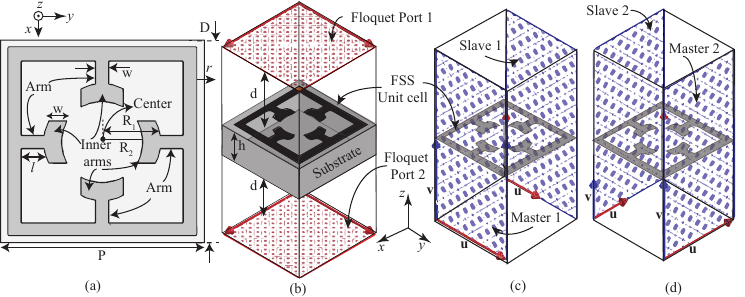
Figure 1. Unit cell geometry of the frequency-selective surface (FSS) and simulation setup for the unit cell investigation. ( a ) Geometry of the proposed miniaturized and symmetric FSS unit cell with optimized dimensions: P = 4.8 mm, L = 4.2 mm, w = 0.3 mm, R 1 = 0.8 mm, and R 2 = 0.8 mm; ( b – d ) FSS unit cell model with periodic boundary conditions and Floquet port assignments.